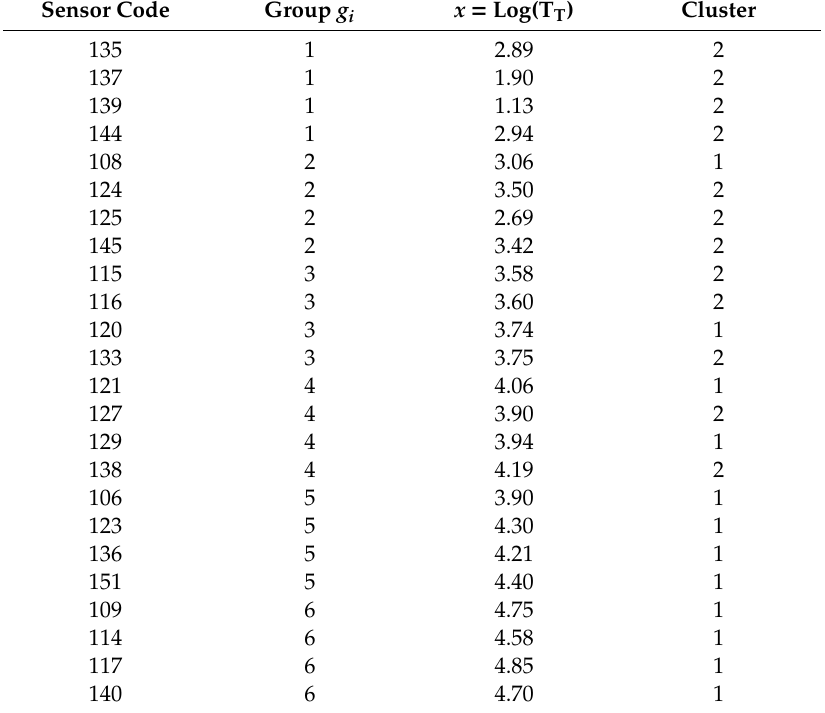
Table 1. Monitoring sensor information: code, group membership, non-acoustic parameter, x = Log(T T ), and cluster membership according to the performed analysis (12 sensors belong to Cluster 1 and 12 to Cluster